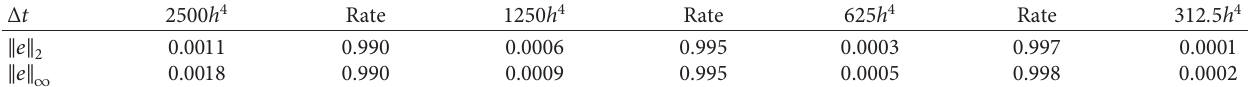
Table 5: Errors and convergence rates for the numerical results of the LSS at the final time T � 10 7 h 4 . Here, h � 1/128 is used. Δ t